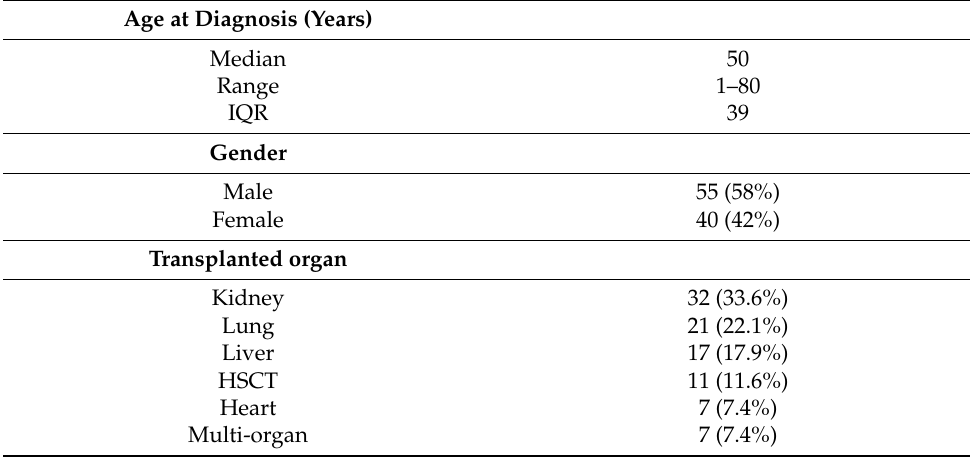
Figure 1. Consort diagram. WHO—World Health Organization Classification of Tumours of Haematopoietic and Lymphoid Tissues 2017. Table 1. Patient characteristics ( n = 96)